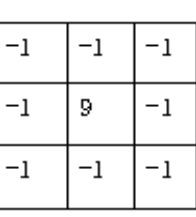
Figure 24. Convolutional kernels of the fourth convolutional layer.